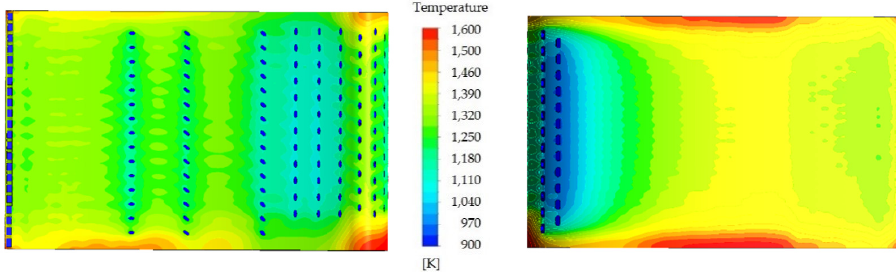
Figure 8. Temperature distribution of the vane’s external surface in data ‐ driven method.